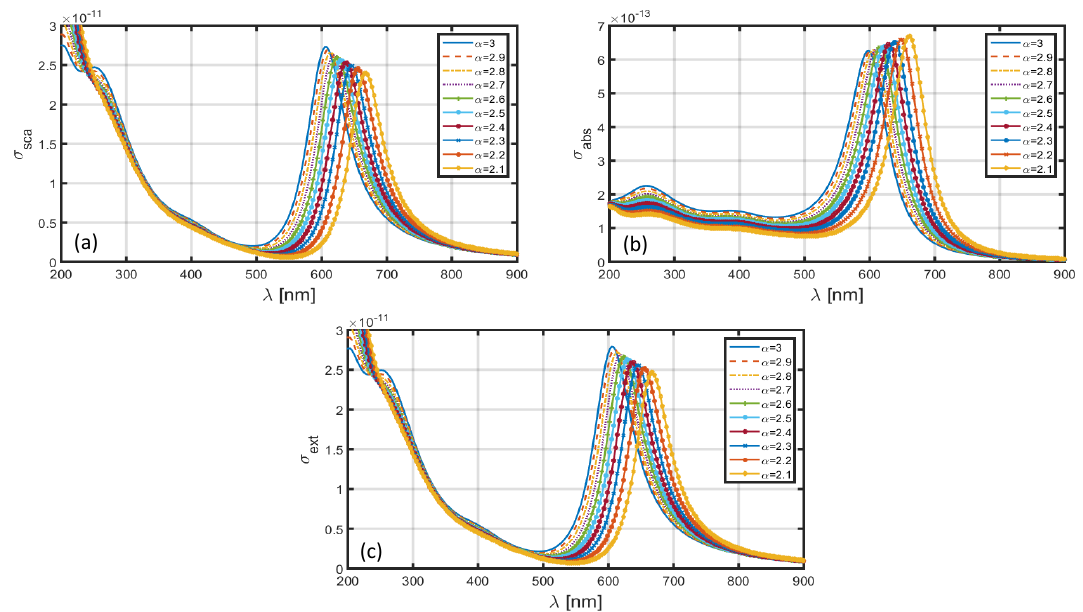
Figure 9. Plots of ( a ) scattering cross-section, ( b ) absorption cross-section, and ( c ) extinction coefficient against λ for SiO 2 -Au nanoparticle in the FD space corresponding to the dimensions a = 60 nm, b = 80 nm.